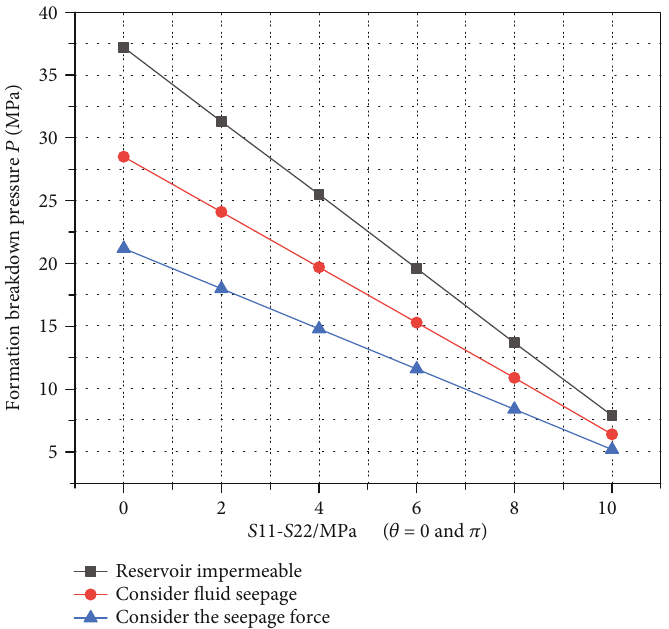
Figure 10: Formation breakdown pressures from the three cases when the di ff erence between S 11 and S 22